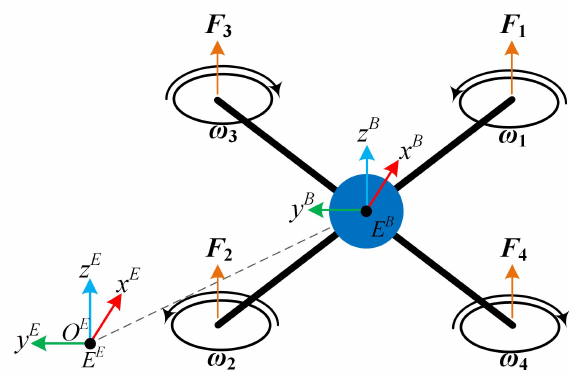
Figure 1. The unmanned aerial vehicle’s (UAV’s) configuration and related variables.